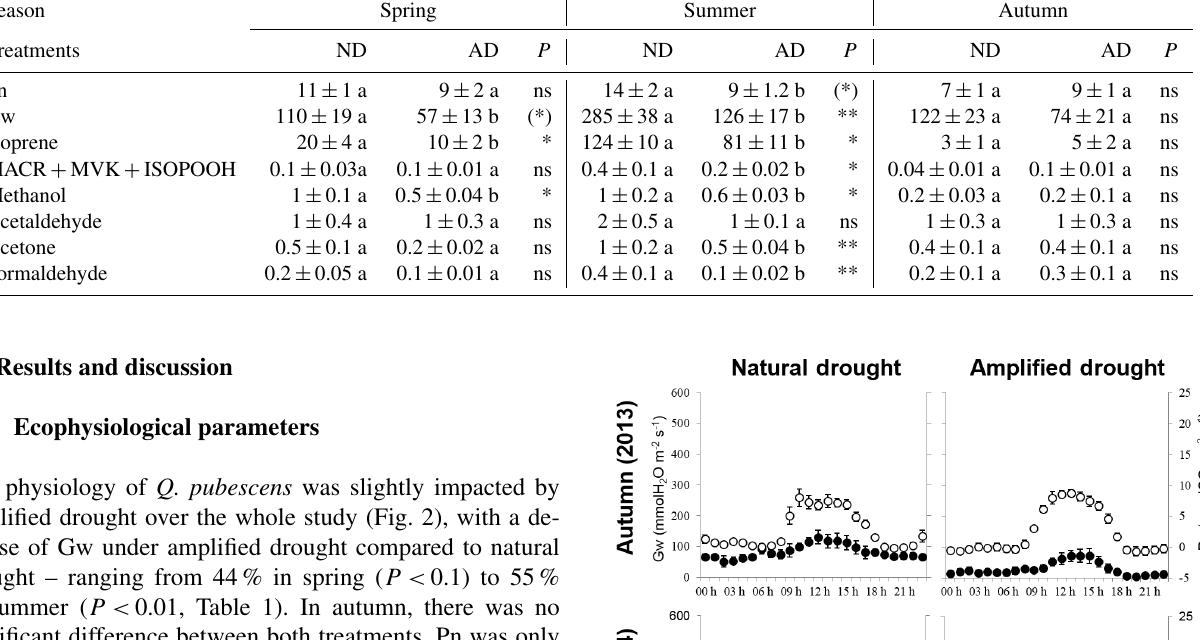
Table 1. Net photosynthesis (Pn, µmolCO 2 m − 2 s − 1 ) , stomatal conductance to water (Gw, mmolH 2 Om − 2 s − 1 ) and emission rates (µgCg − 1 h − 1 ) according to treatment and season. Values represent an average of all data measured between 12:00 and 15:00 (local time). DM Letters denote the difference between drought treatments with a > b and values showed represent the mean ± SE, n = 5. ND is natural drought and AD is amplified drought with ns being non-significant, ( ∗ ) being 0.05 <P < 0.1, ∗ being 0.01 <P < 0.05 and ∗∗ being 0.001 <P < 0.01. Season Spring